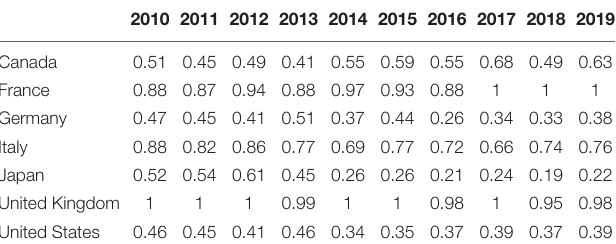
TABLE 2 | Energy efficiency of G7